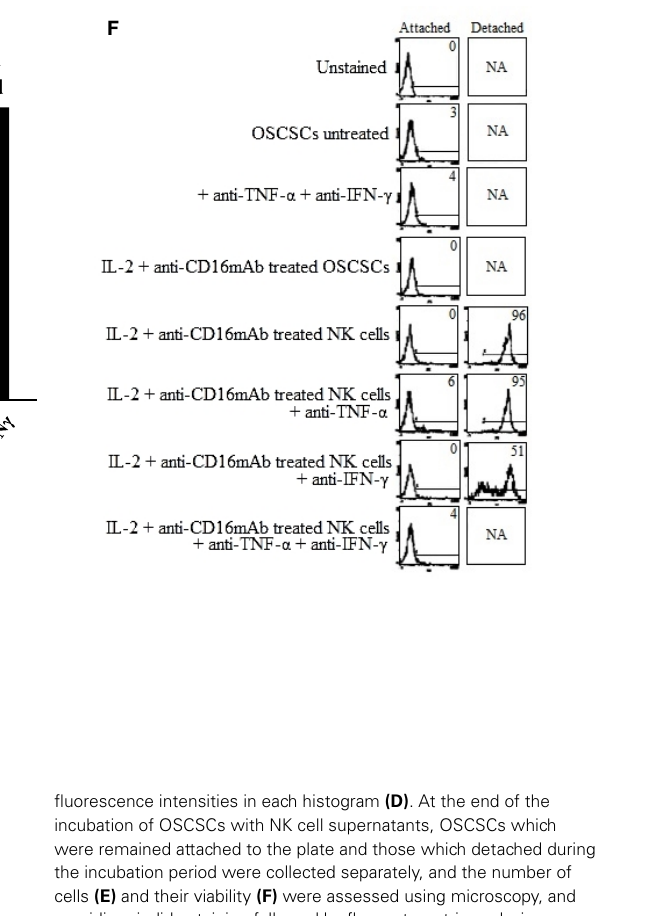
FIGURE 5 | Continued and MHC class I on untreated, anti-TNF- α (1:100) and anti-IFN- γ (1:100) in the absence of NK supernatant, IL-2 + anti-CD16mAb treated NK supernatants in the presence and absence of anti-TNF- α and/or anti-IFN- γ as shown in the figure were assessed were assessed after PE-conjugated antibody staining using flow cytometric analysis. Isotype control antibodies were used as controls.The numbers on the right hand corner are the percentages and the mean channel